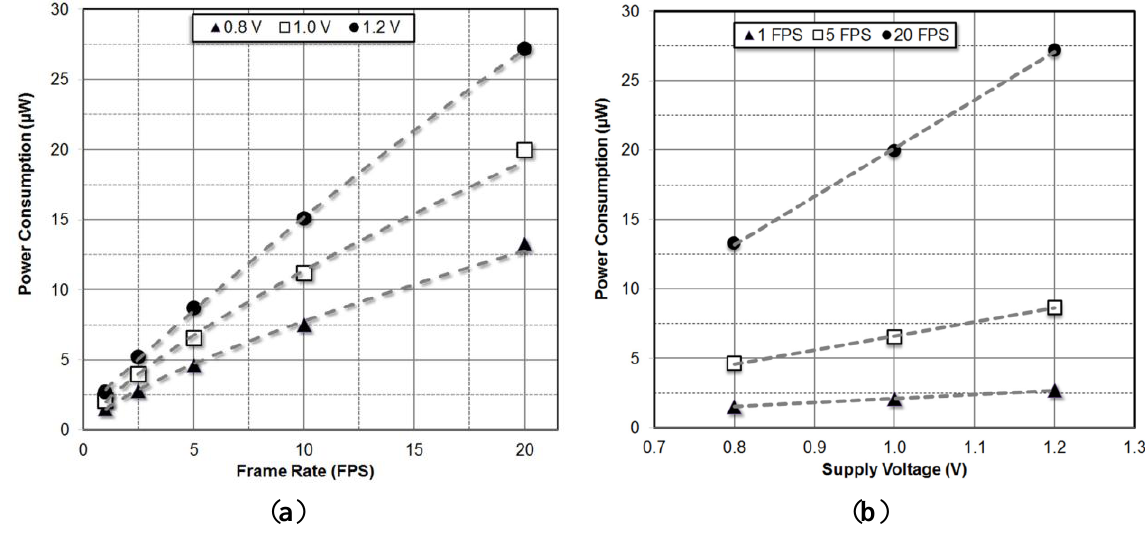
Figure 9. Power consumption of the EHI imager for varying frame rates ( a ) and supply voltages ( b